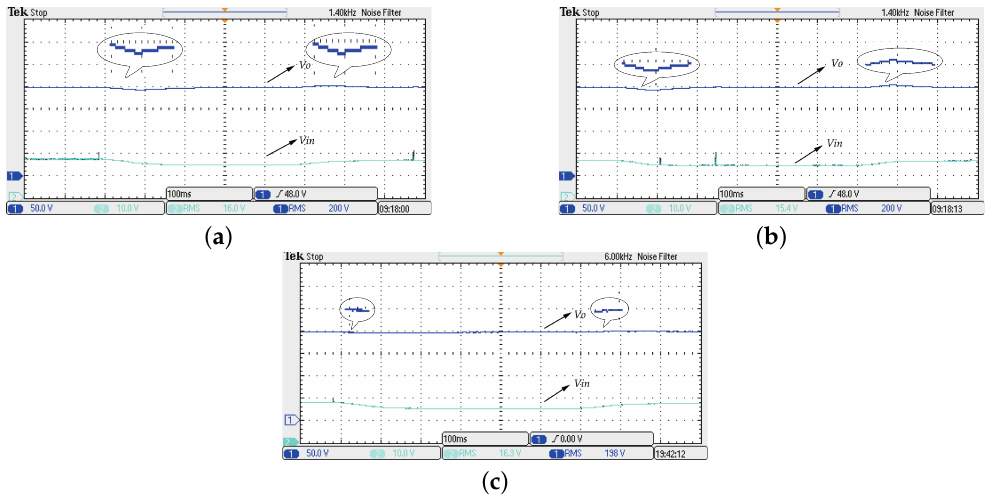
Figure 9. The response of the system versus input voltage variation: ( a ) controlled by the TSM controller ( S 1 ); ( b ) controlled by the FTSM controller ( S 2 ); ( c ) controlled by the proposed NFTSM controller ( S 3